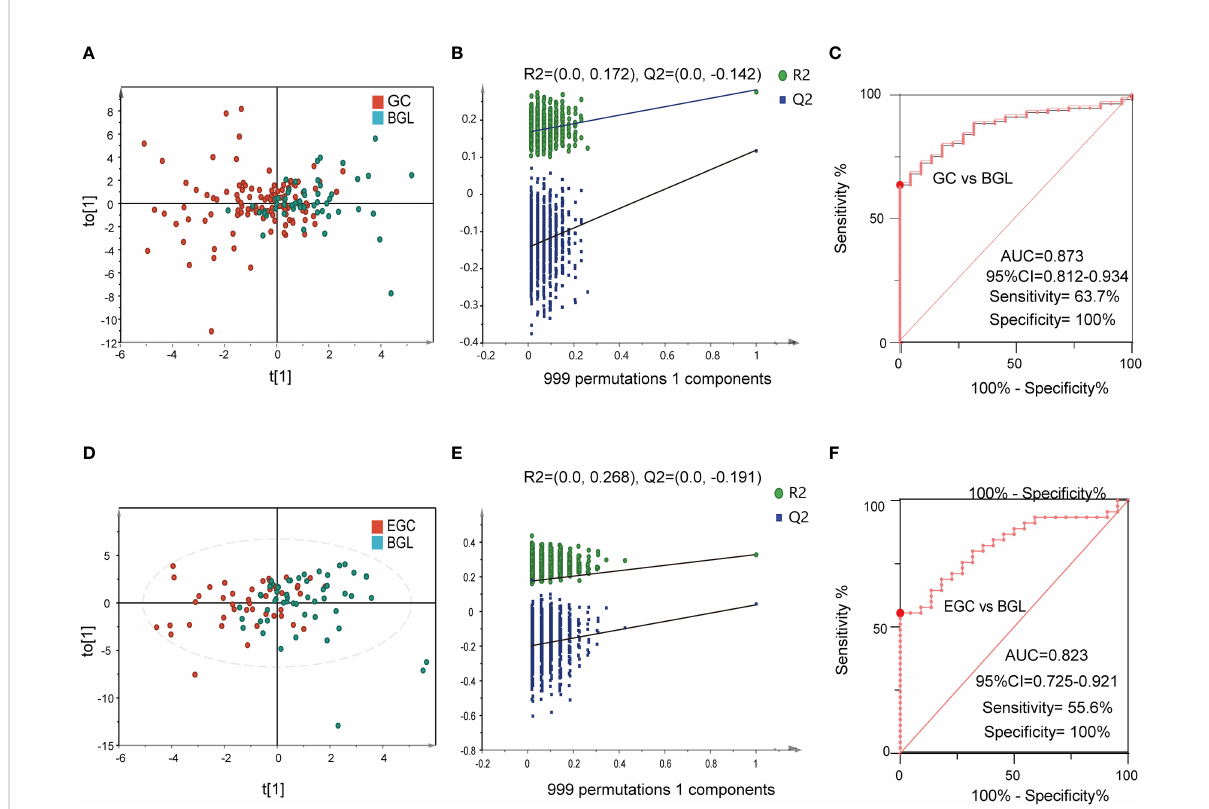
FIGURE 6 The performance of BA biomarkers in distinguishing GC and BGL group. (A) : OPLS-DA score plot of GC and BGL groups. (B) : permutation test result of the OPLS-DA result in (A, C) : ROC curve of 6-BAs diagnostic panel between GC and BGL group. (D) : OPLS-DA score plot of early GC (EGC) and BGL groups. (E) : permutation test result of the OPLS-DA result in (D, F) : ROC curve of 6-BAs diagnostic panel between EGC and BGL